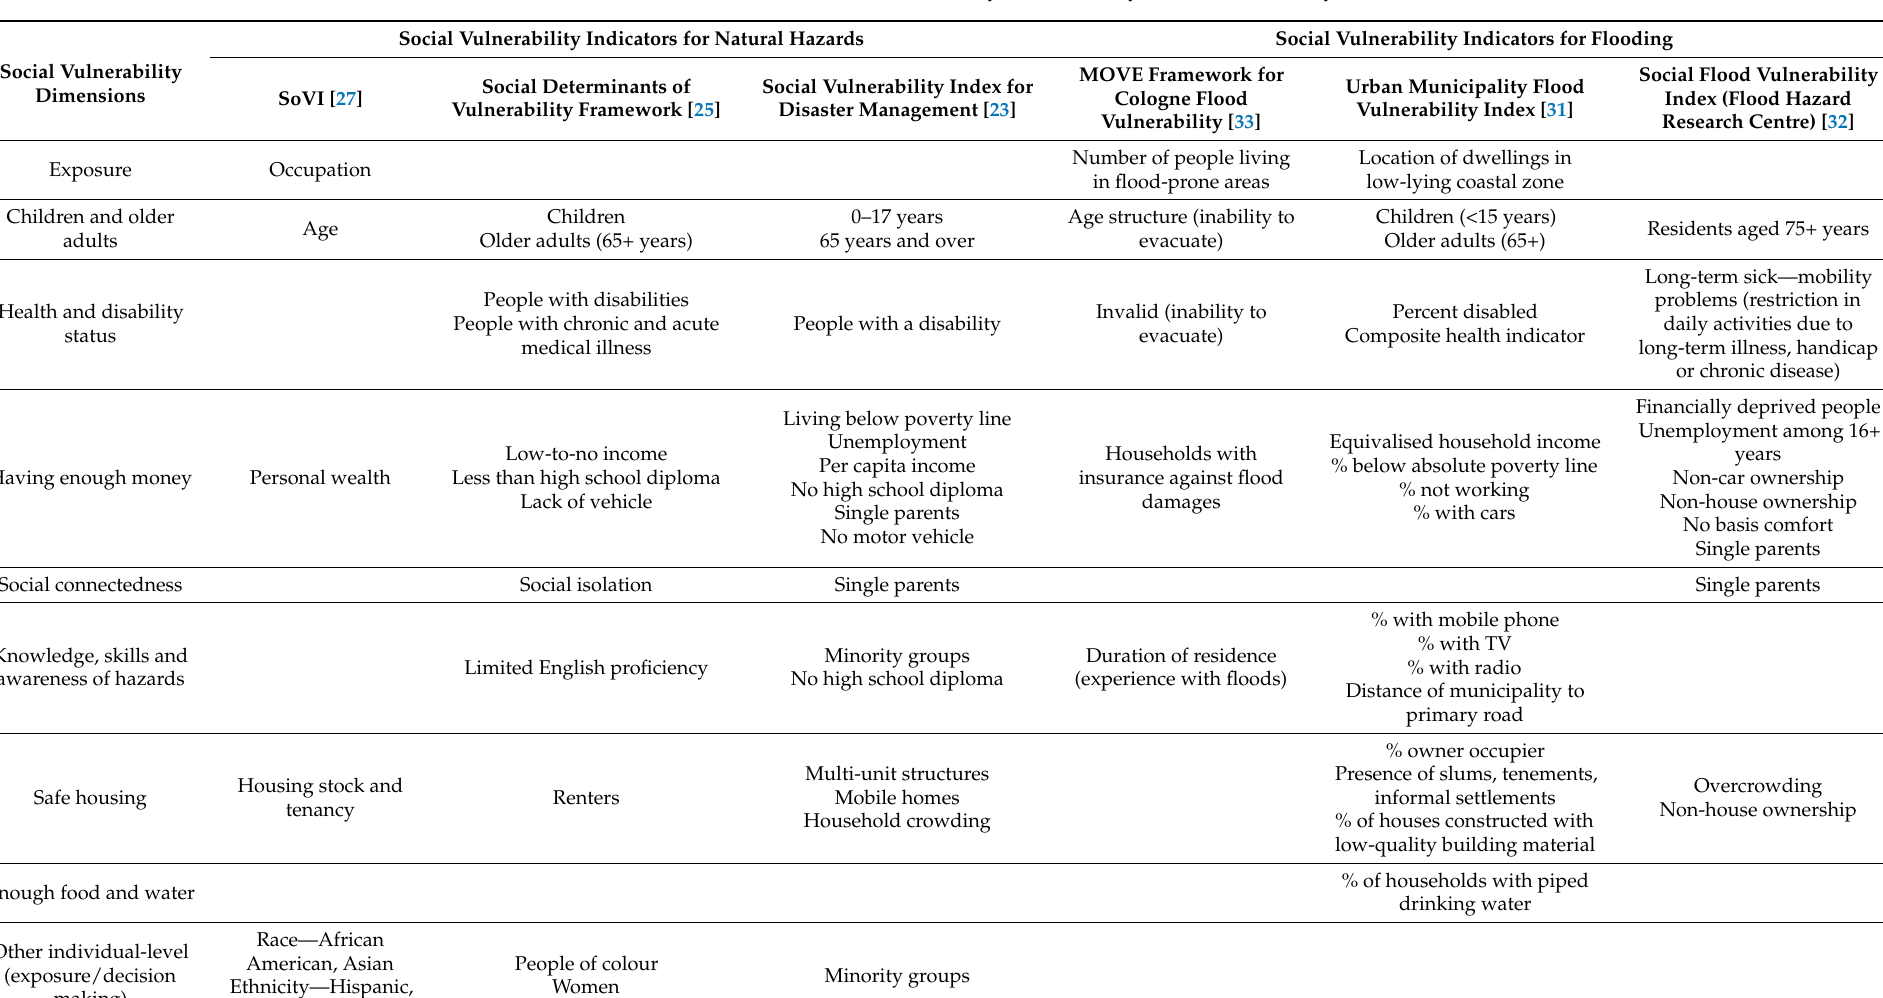
Table A1. Previous sets of international social vulnerability indicators, by social vulnerability